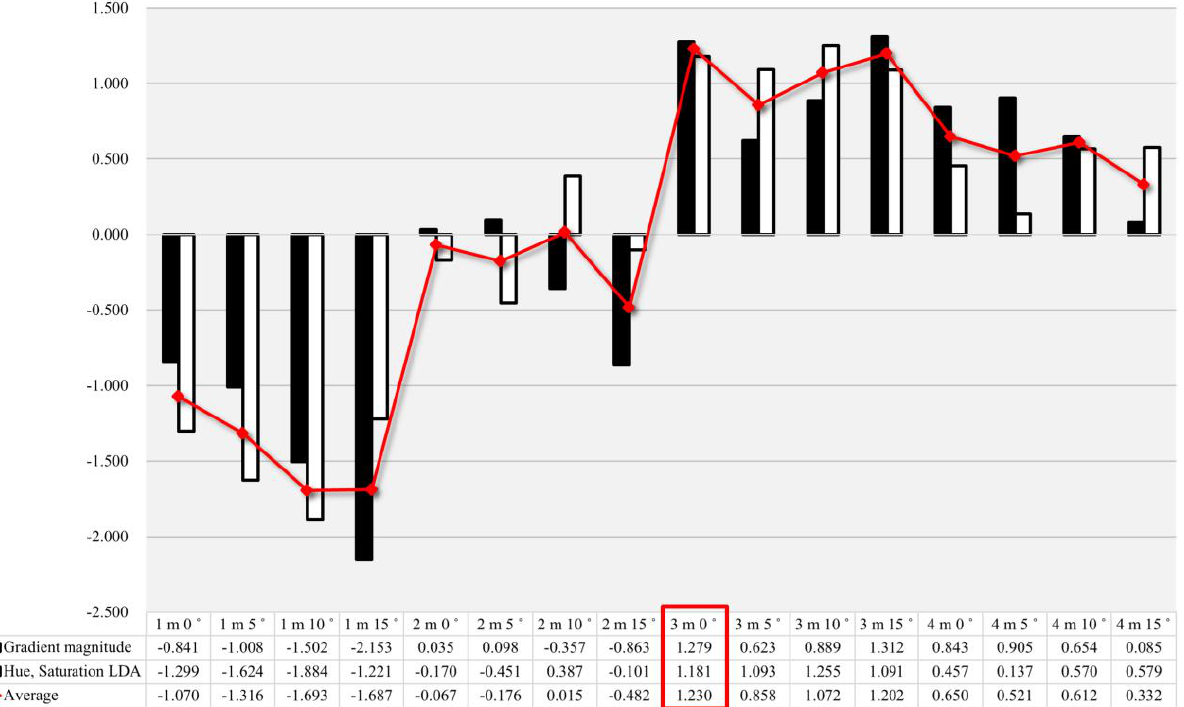
Figure 16. Visualization of LDA results by shooting conditions (The red box indicates the height and angle at which the mean of the gradient magnitude, hue, and saturation LDA is the highest). 3.5. Camera Calibration A large calibration banner measuring 8 × 6 m (width × height) was produced considering that 9 m left and right was imaged at a minimum sensing distance of 6.8 m (Figure 11). To identify the optimal detection position, the drone was fixed on a ladder, and images were taken at 1 m intervals from 6 to 20 m (Figure 17). As shown in Figure 11, the front part of the calibration banner is missing from the field of view at 6 m, whereas the banner is completely within the camera field of view at ≥7 m.